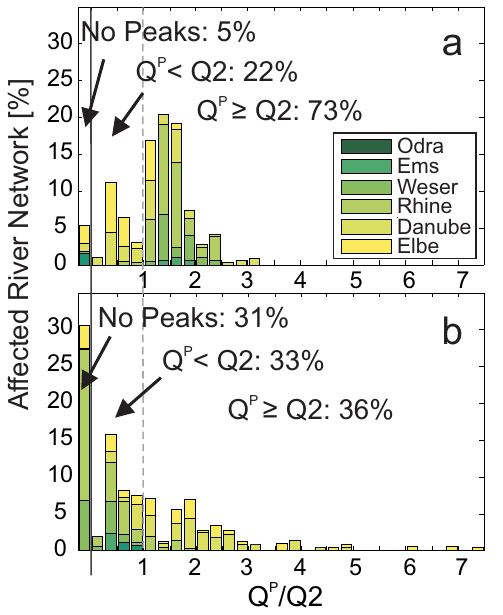
Fig. 5. Histograms of the shares of the river network affected by peak discharges of a certain magnitude for (a) a typical winter flood (Rank 2, February 1970) and (b) a typical summer flood (Rank 12, July 1954). The colour shading is equivalent to that of Fig. 4, high- lighting the contribution of the basins to each column of magnitude.